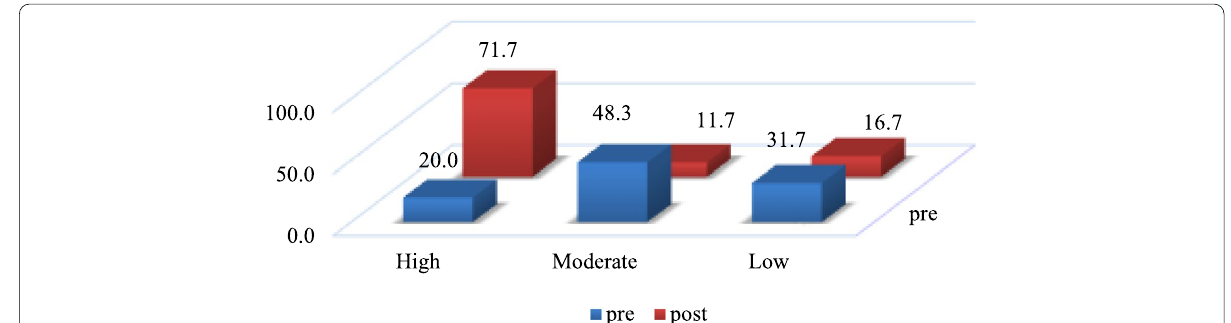
Fig. 6 Total levels of ability of barriers regarding dealing with bullying at school